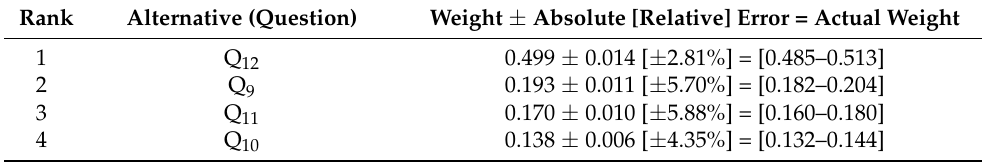
Table 10. Alternatives’ weights and mean errors.